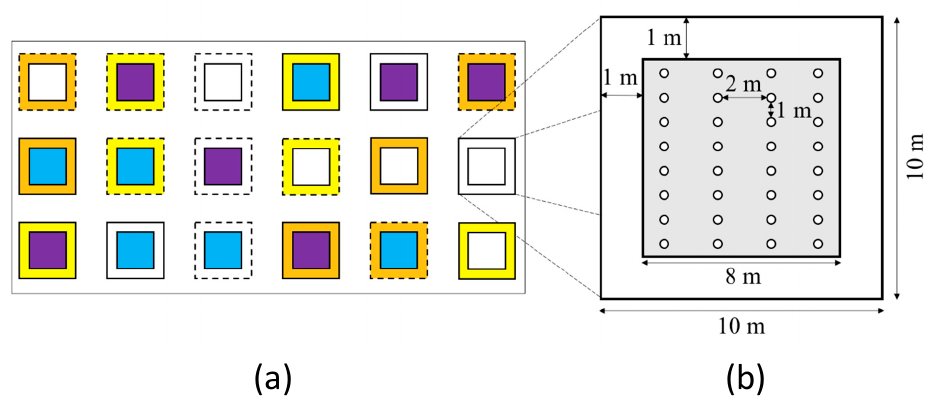
Figure 6. Experimental study design. ( a ) Exemplary presentation of a randomized block ( n = 11) with 18 different plot variations. Outer square colors mark treatments applied to P. serotina : felling (yellow), girdling (orange), control (white); inner square colors mark underplanted tree species: F. sylvatica (blue), T. cordata (purple), no underplanting (control, white); Outer line type indicates protection: solid line (fenced), dashed line (unfenced). All plots were placed at 5 m distance from skidding trails. ( b ) Planting scheme on each 100 m 2 plot. Fenced plots had 1 m distance between seedlings and fence. Plant spacing was 2 × 1 m, resembling a density of 5000 plant ha − 1 .